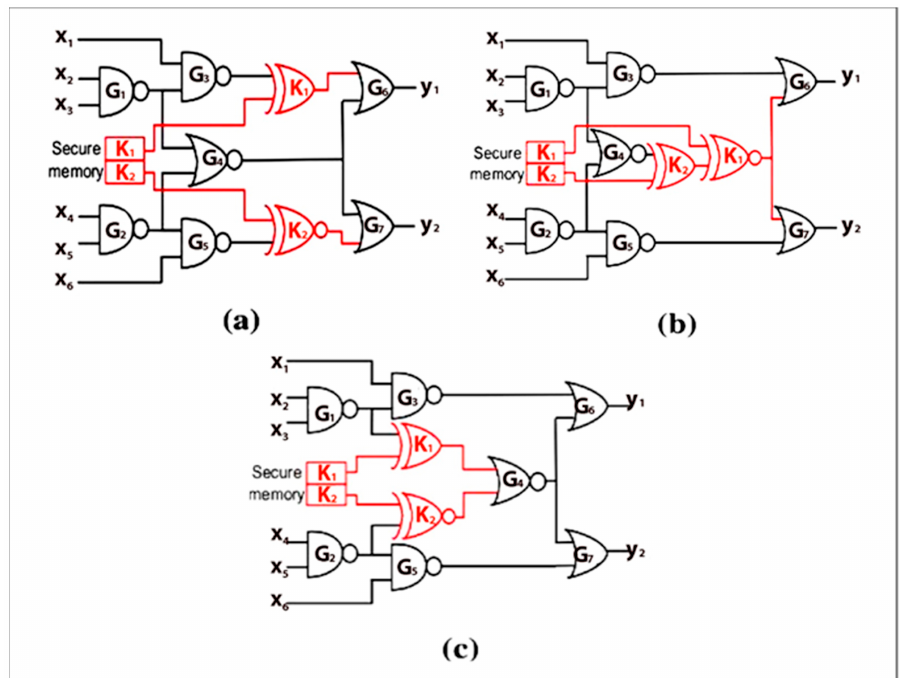
Figure 3. ( a ) Random logic locking, ( b ) fault analysis-based logic locking, ( c ) interference-based logic locking [18].